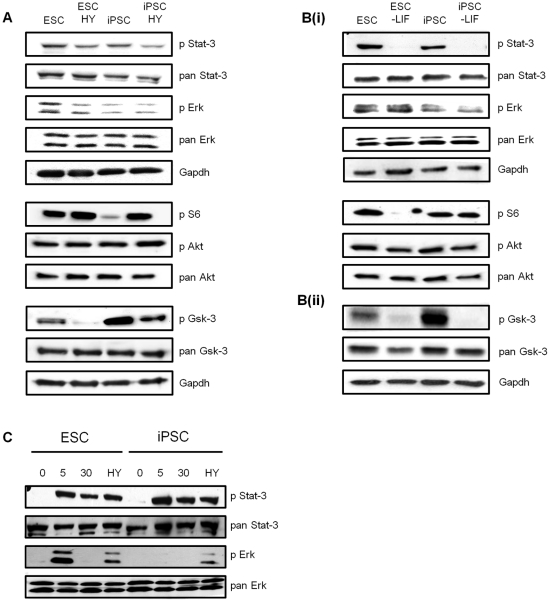
Expression and phosphorylation status of key signaling intermediates in ESCs and iPSCs.
A and B ESCs or iPSCs were seeded 8000 cells/cm2 in KO SR plus LIF. After 24 hours, 10% (v/v) Hyclone serum (HY) was added where indicated (A), or cells were washed 3 times with PBS before LIF-containing or LIF-free KO SR was added to the cultures as indicated (B). After a further 24 hours incubation, protein extracts were prepared, separated through 10% acrylamide gels using SDS-PAGE and immunoblotted using the antibodies indicated. Blots in A and B(i) were all generated using cell extracts from one replicate and those in B(ii) from an independent experimental replicate. C ESCs or iPSCs were seeded at 8500 cells/cm2 in GMEM 10% (v/v) Hyclone serum (HY) plus LIF, then 24 h later washed and deprived of LIF and serum for 4 h. 5000 U/ml of LIF or 10% (v/v) HY were added and proteins extracted following 0, 5, 30 min treatment with LIF or 30 min treatment with serum. The phospho-proteins indicated were detected by immunoblotting of the same membrane, which had been cut referring to the size of the protein marker, then stripped and re-probed with the corresponding pan antibody. Results generated from the same blots are grouped, with each series terminating with the respective Gapdh as loading control.